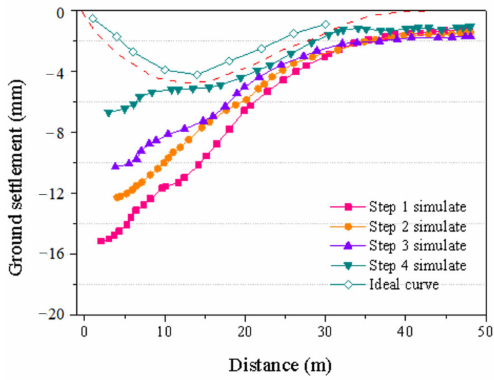
Figure 11. Ground settlement through excavation.